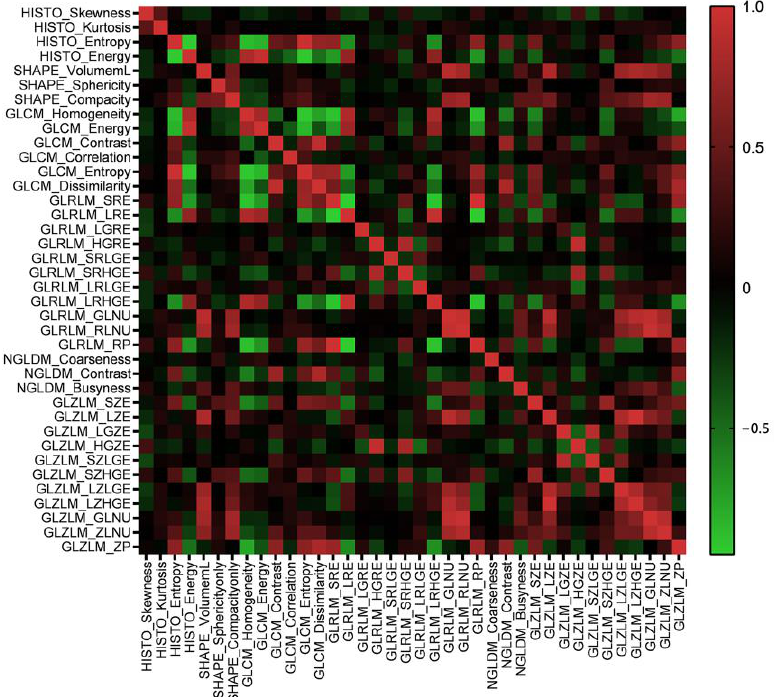
Figure 2. The heat map of Pearson’s correlation coefficients among radiomics features.